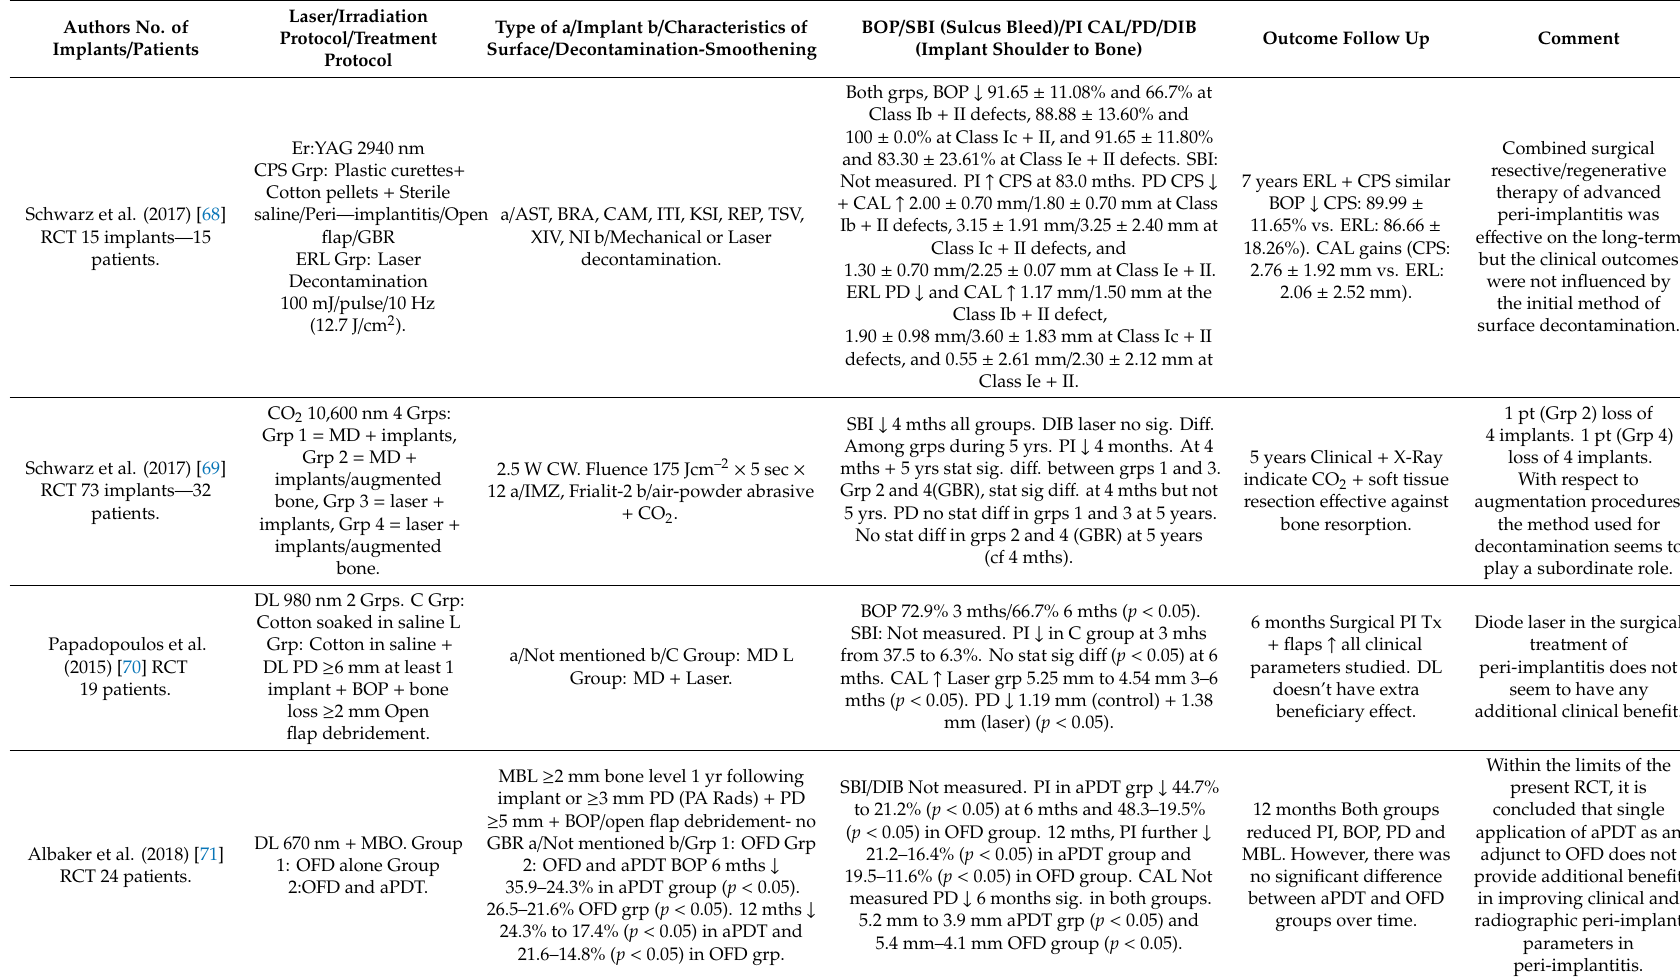
Table 3. Analysis of peri-implantitis, surgical